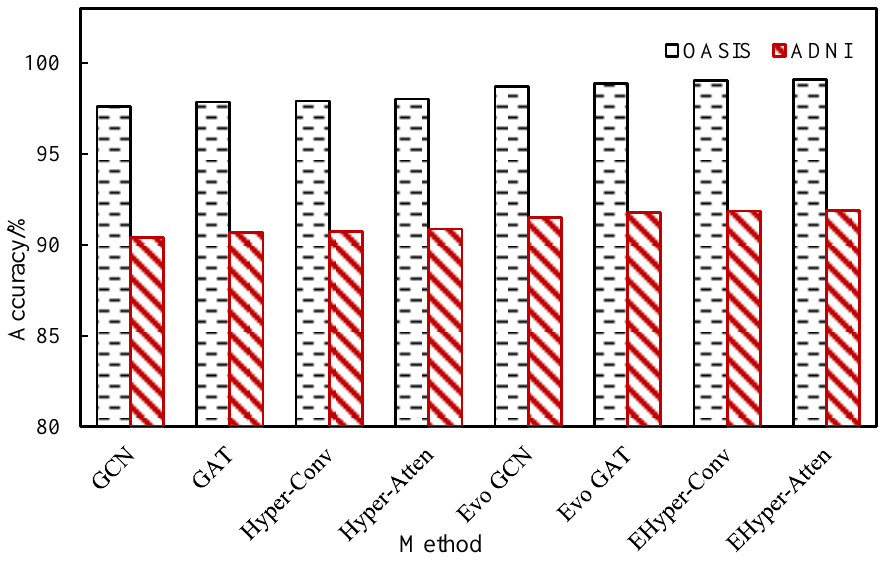
Figure 4. The comparison method in two data